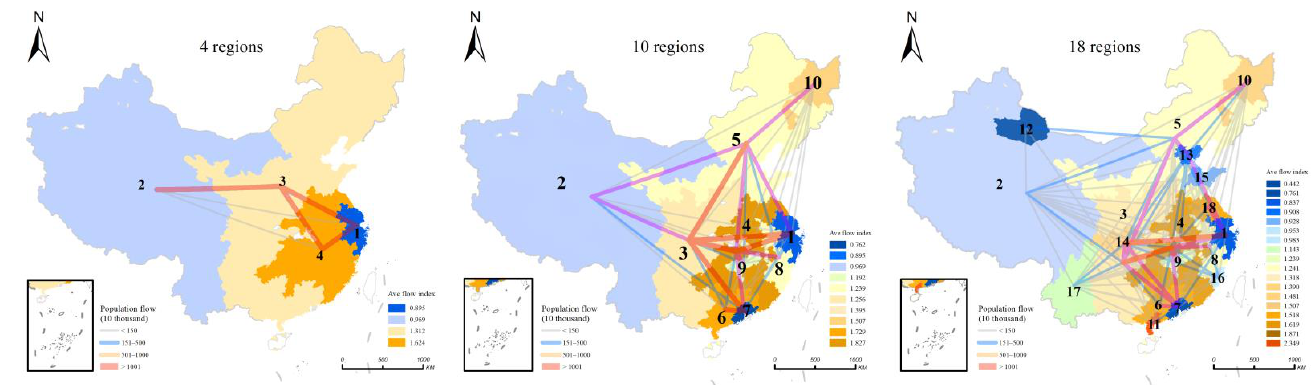
Figure 5. The “source -flow- sink” system of population flow during Spring Festival Transport in 2015 in China. Next, the model divides ten regions to refine the regionalization pattern of popula- tion flow (Figure 5). There is basically no change between the Yangtze River Delta region